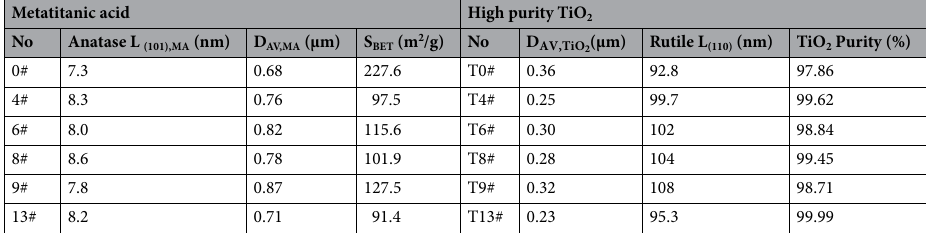
Table 5. Effects of hydrothermal conditions on the structure and TiO 2 content for metatitanic acid and TiO 2